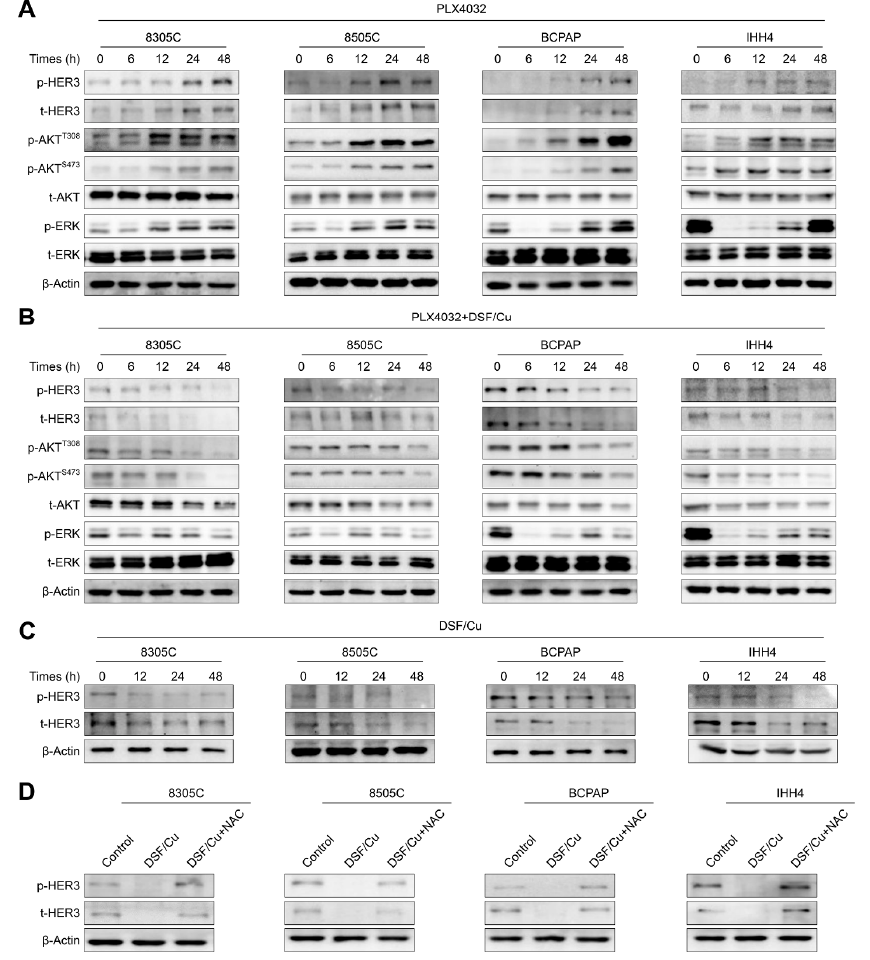
Figure 5. DSF/Cu relieves the rebound of MAPK/ERK and the activation of PI3K/AKT pathways caused by PLX4032. ( A ) The indicated cells were treated with 4 µ M PLX4032 for 0 h, 6 h, 12 h, 24 h and 48 h, and Western blot analysis was then used to detect the levels of phosphorylated HER3 (p- HER3 ), total HER3 (t- HER3 ), p-AKT S473 , p-AKT T308 , t-AKT, p-ERK and t-ERK. ( B ) These cells were treated with the combination of 4 µ M PLX4032 and 0.5 µ M DSF/Cu, and Western blot analysis was similarly performed to detect the levels of the above molecules. ( C ) The same cell lines were treated with 0.5 µ M DSF/Cu for 0 h, 12 h, 24 h and 48 h, and Western blot analysis was used to determine the levels of p- HER3 and t- HER3 . ( D ) Western blot analysis of p- HER3 and t- HER3 in the indicated cells treated with 0.5 µ M DSF/Cu alone or in combination with 2 mM NAC. β -Actin was used as a loading